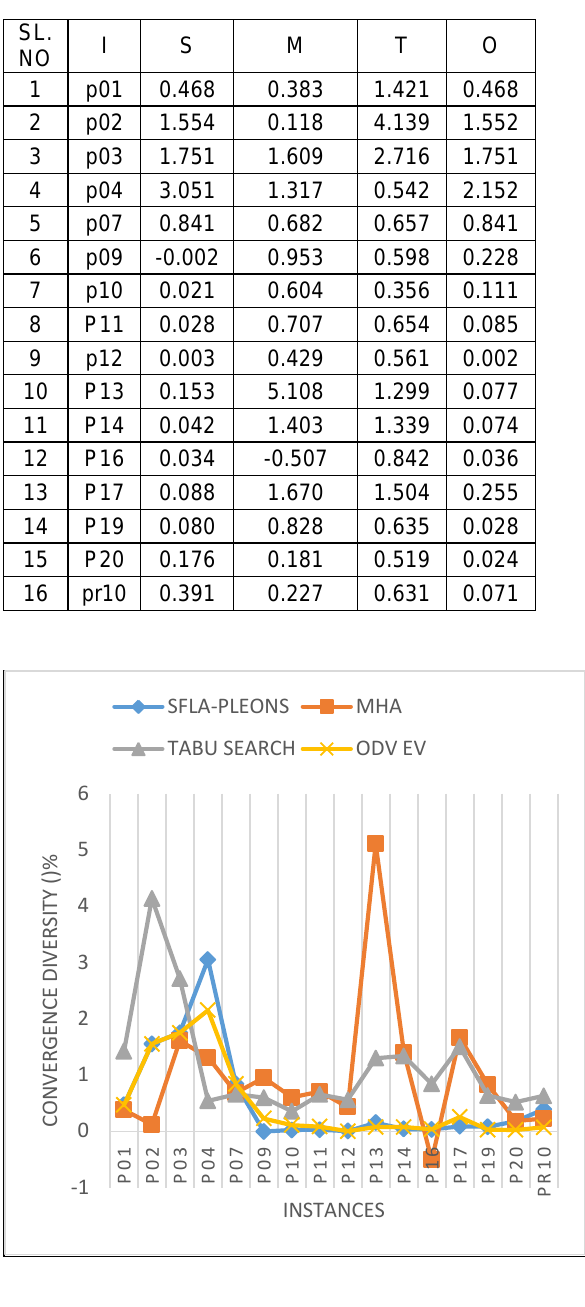
Table 4. Experiment results w.r.t Convergence Diversity (%)